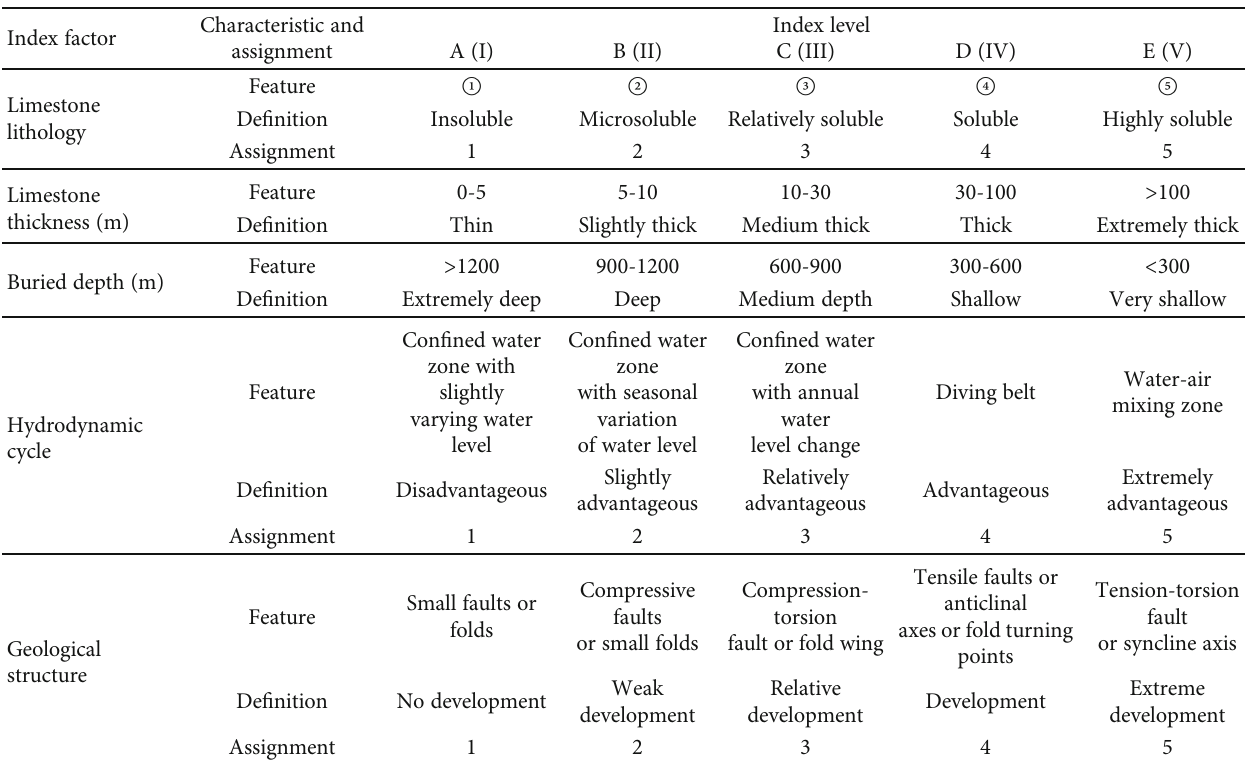
Table 4: Classi fi cation of evaluation indexes for the karst development